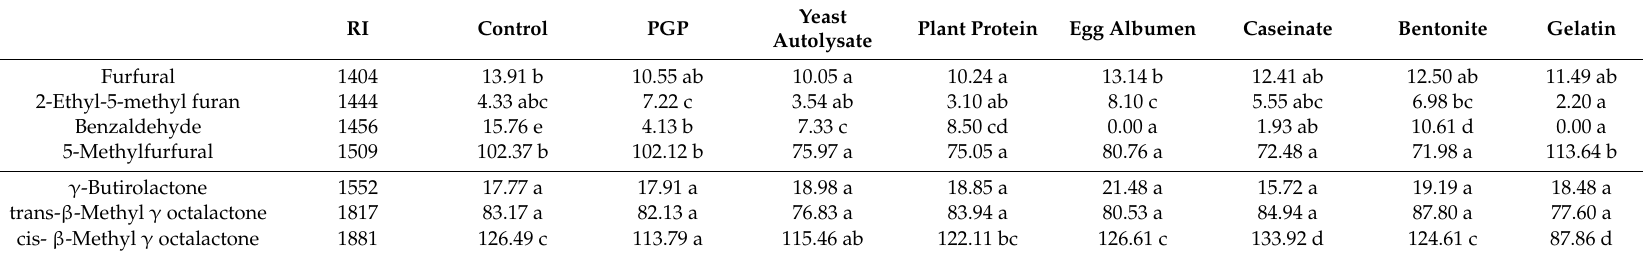
Table 4. E ff ect of the fining agents on phenol and carbonyl + lactone compounds ( µ g equivalents of 2-octanol /